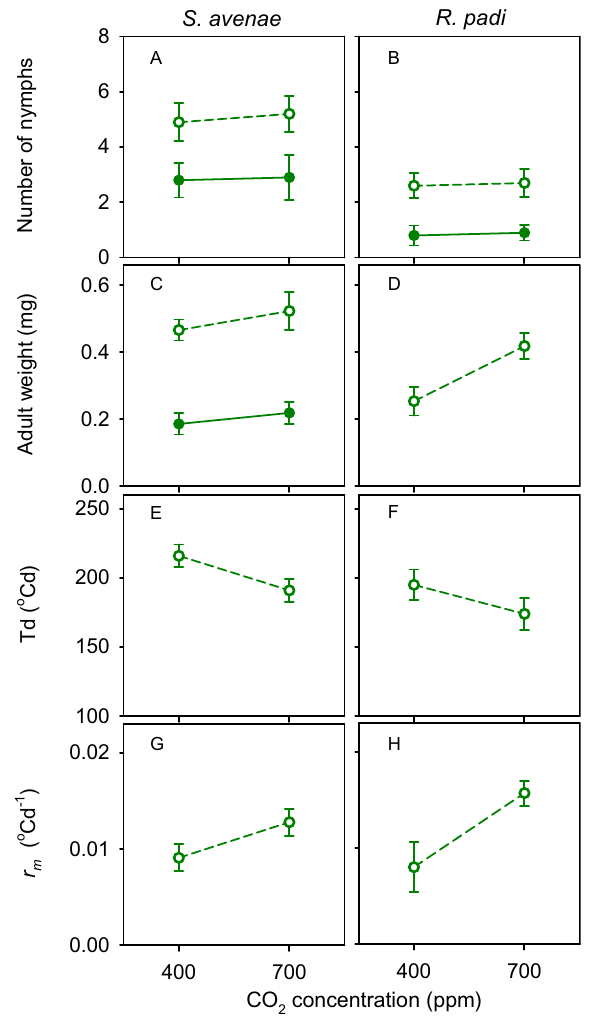
Figure 4. ( A , B ) Number of S. avena e and R. padi nymphs laid by a 2 – 3 d old adult over 48 h on wheat leaves in response to nitrogen supply (high: closed symbol, low: open symbol), [CO 2 ] and their interaction. ( C , D ) Weight of adults at the onset of reproduction; no R. padi survived to adulthood under high nitrogen. ( E , F ) generational time Td and (G, H) intrinsic rate of natural increase r m for R. padi and S. avenae on wheat leaves under low nitrogen and two [CO 2 ]. Error bars are two standard errors of the